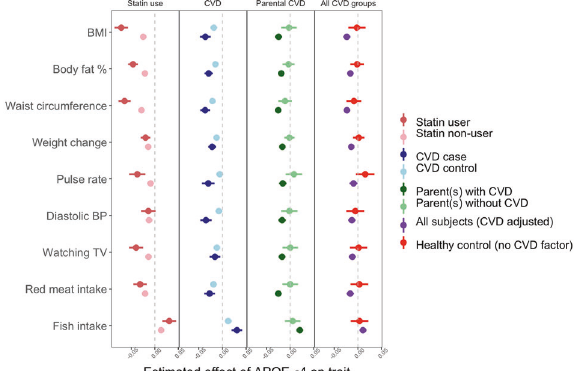
Fig. 3 Differential effect of APOE- ε 4 on selected health traits according to cardiovascular disease (CVD) status. All the models are adjusted for the standard covariates including age, sex, age 2 , age*sex interaction term, socioeconomic status based on Townsend deprivation index, genotyping batch, assessment centre, and the fi rst 12 principal components of ancestry as covariates. In the model of all subjects (CVD adjusted), indicated by red colour, 3 CVD factors including statin use, CAD and parental CAD and lifestyle score are additionally adjusted. There are 53,173 statin users and 270,745 sta- tin non-users in the data, 94,170 CVD cases and 229,104 CVD controls, and 232,286 participants with a parent with CVD and 46,914 with parents without